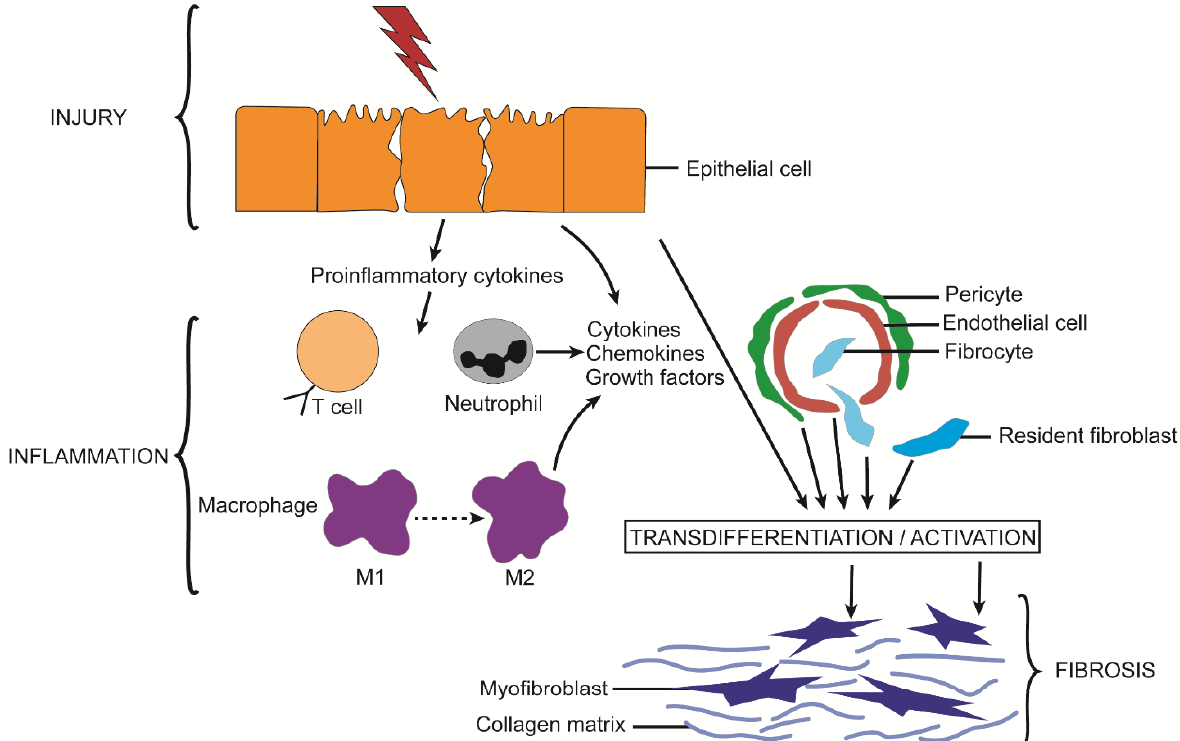
Figure 1. Principal cellular events leading to fibrosis. Injury to epithelial cells results in their release of pro-inflammatory cytokines, which is a stimulus for infiltration of macrophages and immune cells to the injury site. This results in an inflammatory environment in which cytokines, chemokines, and growth factors are produced that drive the production and action of contractile α SMA-producing myofibroblasts. Myofibroblasts arise by activation of resident fibroblasts or circulating fibrocytes or are the result of transdifferentiation from other cell types such as epithelial cells, endothelial cells, or pericytes. In acute injury, myofibroblasts transiently produce ECM components such as collagen, laminin, and FN which are necessary for normal wound healing, and parenchymal repopulation. During persistent or recurrent episodic injury, the inflammatory phase is protracted leading to unrelenting myofibroblastic activity, which is manifested as excessive production of ECM components that are deposited in the interstitial space as scar material, or fibrosis.